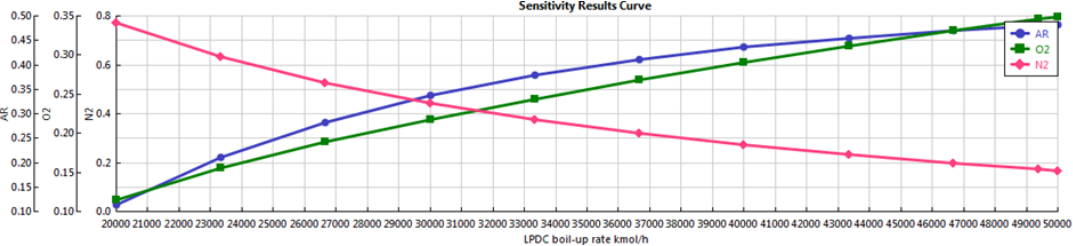
Figure 12. ARO2RECT molar fractions vs. LPDC Boil-up rate.